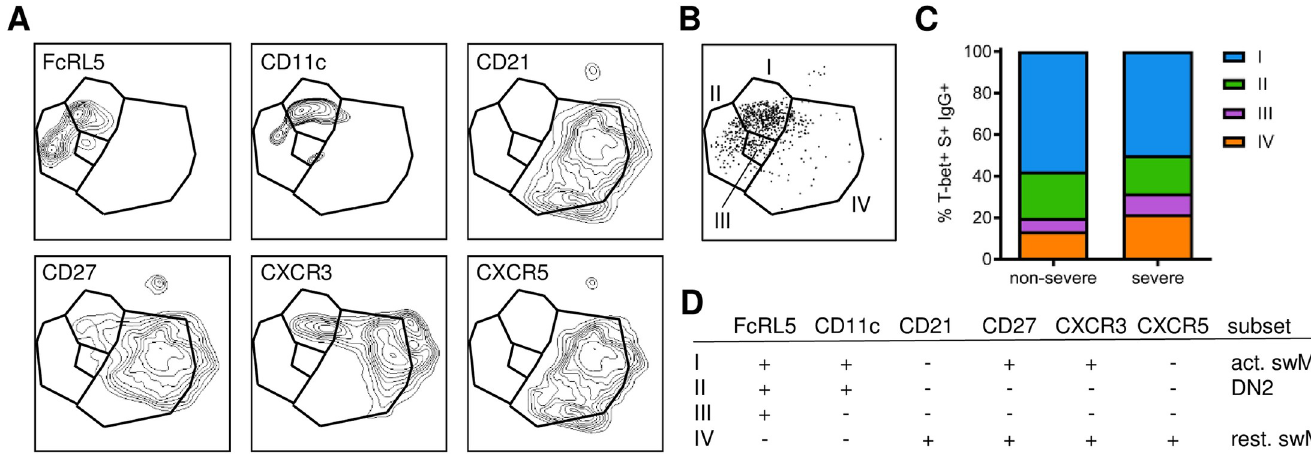
Fig 5. The phenotype of T-bet + IgG + spike-specific B cells. A) UMAPS showing the expression of individual markers in T-bet + IgG + spike-specific B cells. B) Gating of four populations of T-bet + IgG + B cells based on unique expression profiles of the markers shown in panel A. C) Distribution of the four T-bet + IgG + B cell population among individuals who recovered from non-severe (n = 7) and severe (n = 5) COVID-19. D) Summary of the phenotype of the four T-bet + IgG + B cell populations identified here and their classification into one of the major B cell subsets: activated switched memory (act. swM), DN2, or resting switched memory (rest. swM) B